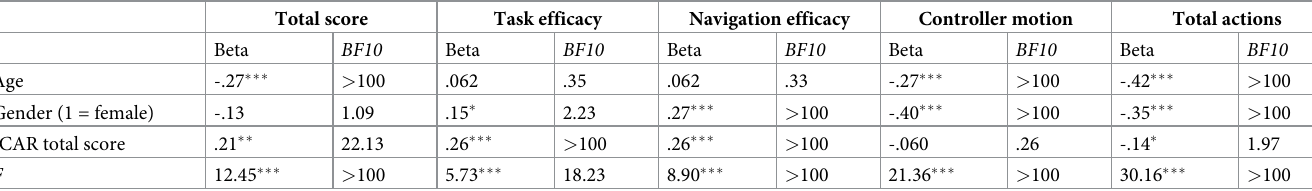
Table 10. Associations between the background factors age, gender, and intelligence (ICAR score) and the key EPELI